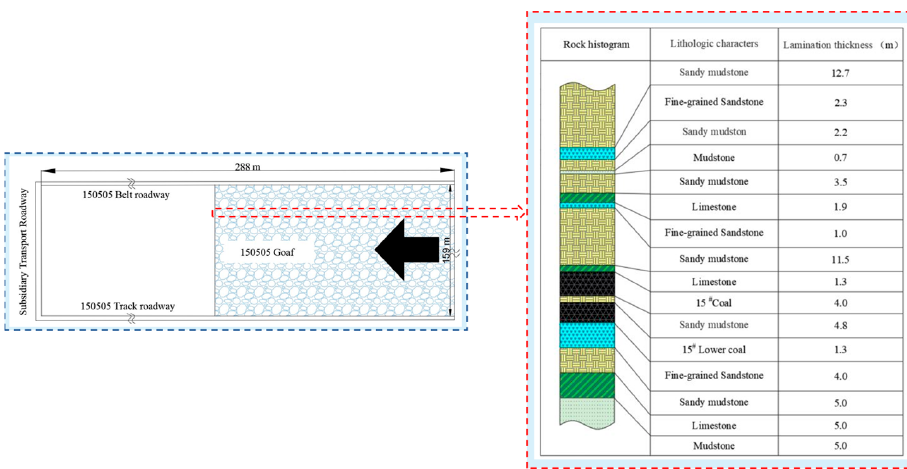
Figure 1. 150505 working face layout relationship and comprehensive